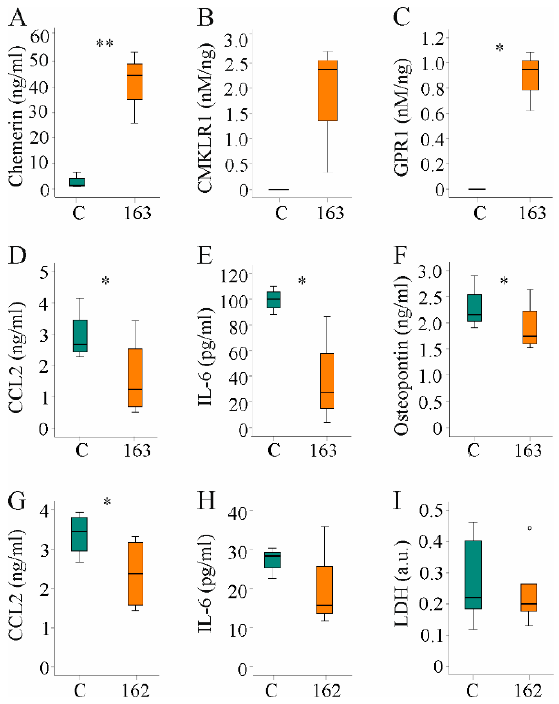
Figure 7. Hepatocyte supernatant of huChem-163 expressing Huh7 cells lowered inflammatory proteins in human peripheral blood mononuclear cells (PBMC) media and supernatant of Hepa1–6 cells reduced CC-chemokine ligand 2 (CCL2) in RAW264.7 cell media: ( A ) Chemerin in the supernatant of Huh7 cells transfected with an insert-less plasmid ( C ) or a plasmid to express huChem-163 ( n = 4); ( B ) Chemokine-like receptor 1 (CMKLR1) activation by the supernatant of Huh7 cells transfected with an insert-less plasmid ( C ) or a plasmid to express huChem-163 relative to total cell media chemerin ( n = 3); ( C ) G protein-coupled receptor 1 (GPR1) activation in these cells ( n = 3); ( D ) Cell media CCL2 levels of PBMCs cultivated in the supernatant of Huh7 cells transfected with a control plasmid or overexpressing huChem-163 ( n = 4); ( E ) Interleukin (IL)-6 and ( F ) osteopontin in the media of these PBMCs ( n = 4); ( G ) Cell media CCL2 levels of RAW264.7 cells cultivated in the supernatant of Hepa1–6 cells overexpressing muChem-162 ( n = 4); ( H ) IL-6 in these cell media ( n = 3); ( I ) Lactate dehydrogenase (LDH) in these cell media ( n = 6). Student’s t -test, * p < 0.05, ** p < 0.01. Outliers = values between 1.5 and 3 times the interquartile range are shown as circles.